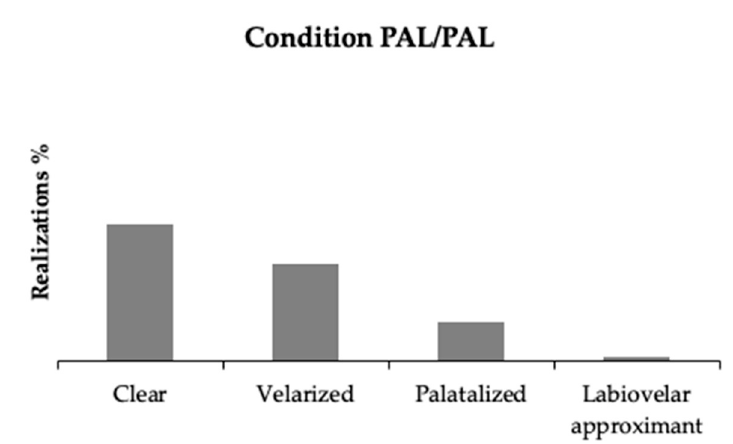
Figure 3. The production of the L3 lateral in condition PAL/PAL.